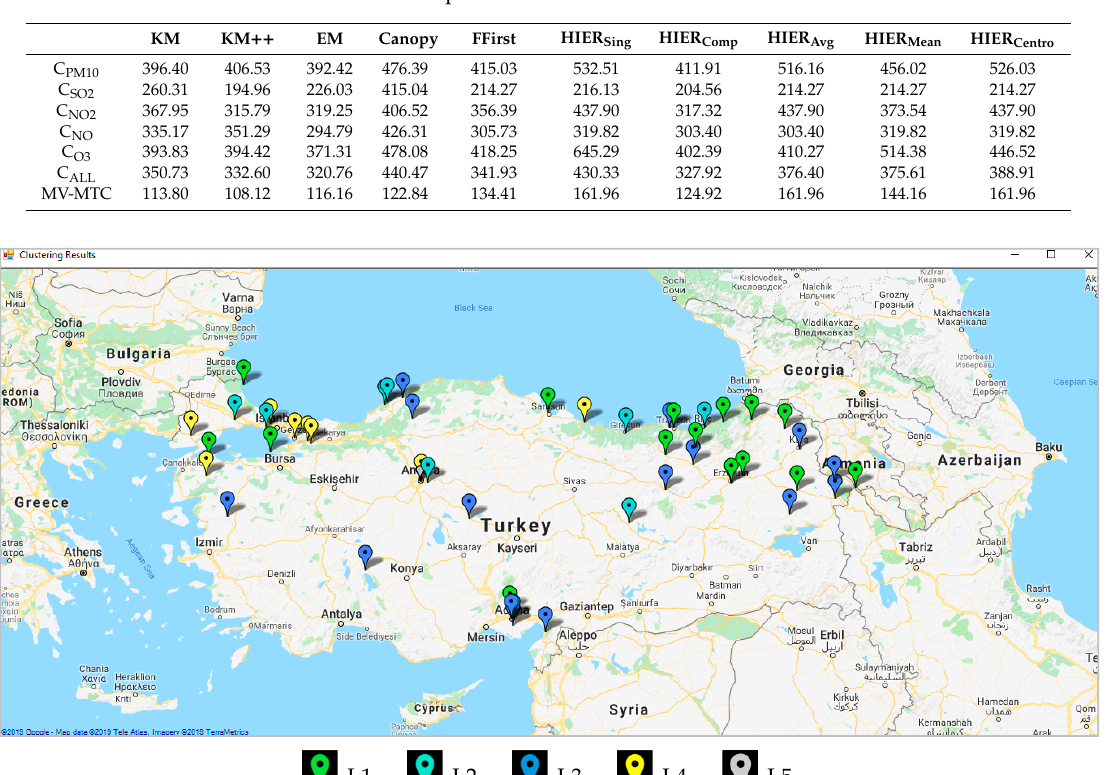
Table 9. The results of the performance evaluation in terms of SSE values.